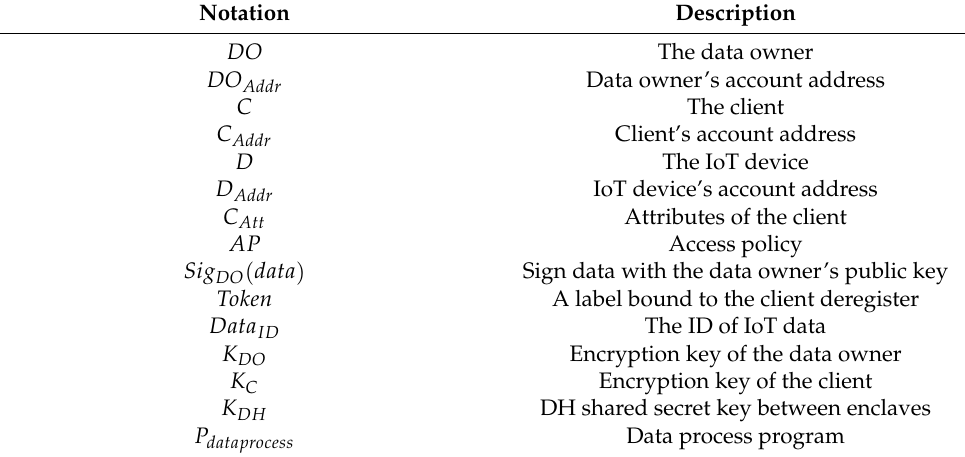
Table 3. Notations .